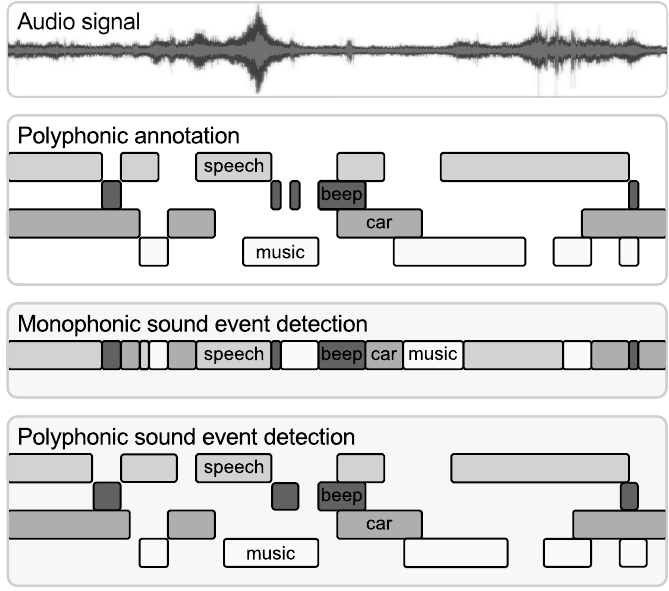
Figure 2. Illustration of the output of monophonic and polyphonic sound event detection systems, compared to the polyphonic